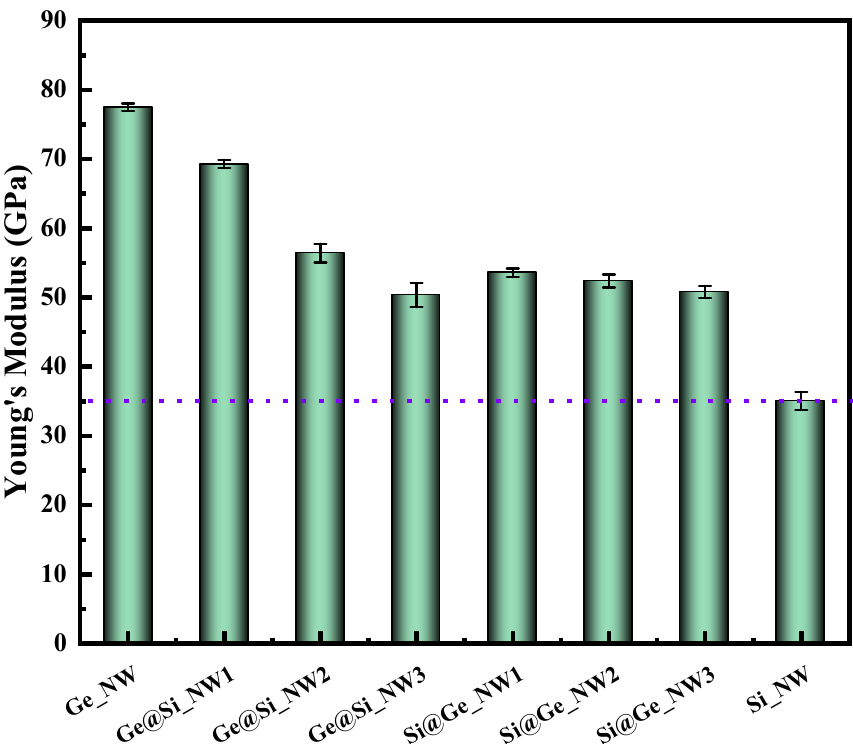
Figure 5. Young’s modulus of Ge@Si and Si@Ge nanowires with different core–shell ratios at 300 K. Figure 6a shows the distribution of Lode–Nadai parameters for the Ge@Si and Si@Ge